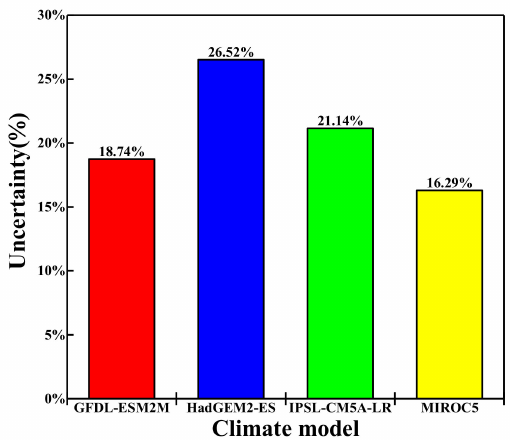
Figure 10. Uncertainty in the estimation of NPP based on CASA model in four climate